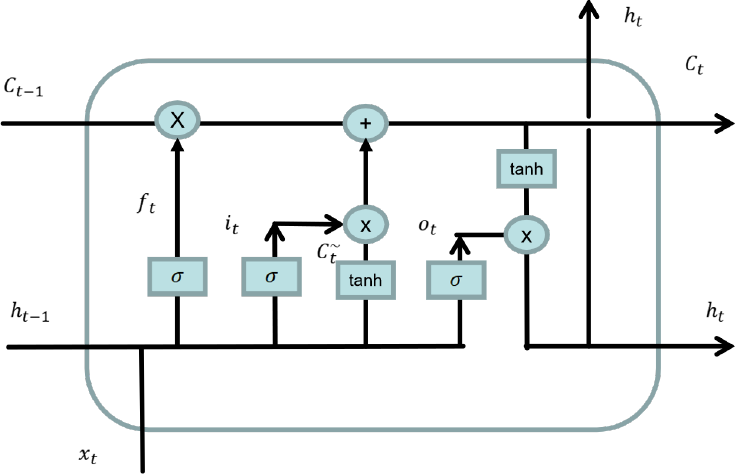
Figure 8. Unidirectional LSTM unit